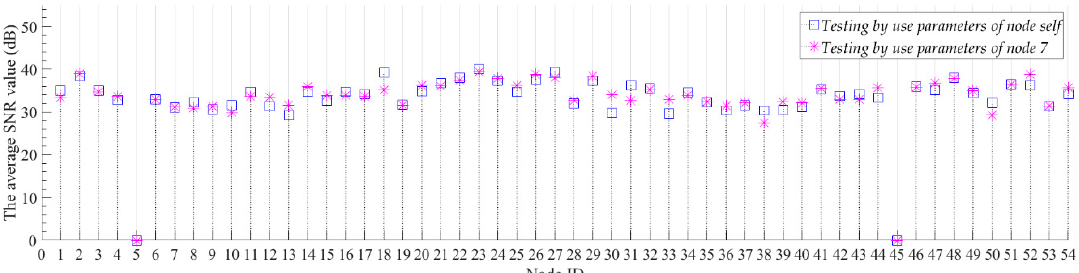
Figure 7. The average SNR values of models with different model parameters for all nodes. The blue box denotes the average SNR value of the model which testing by use the parameters of node self. The upper and lower boundaries of the blue box correspond to the plus or minus 1 dB range of the result value. The ‘ ’ symbol denotes the average SNR value of the model which testing by use the parameters of Node 7.